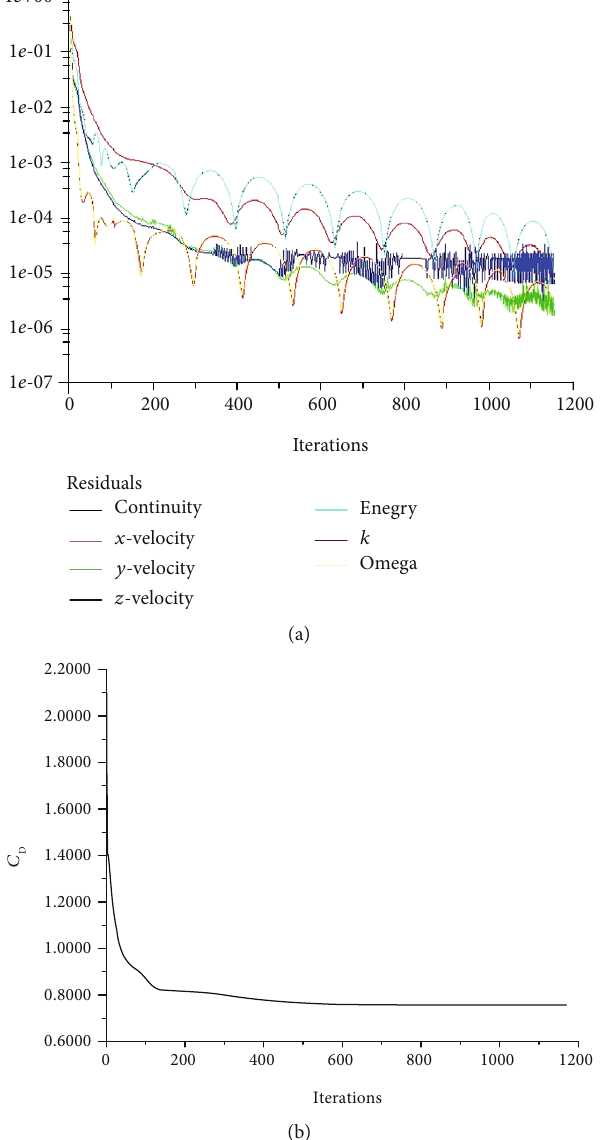
Table 1: Di ff erences between the numerical and experimental results